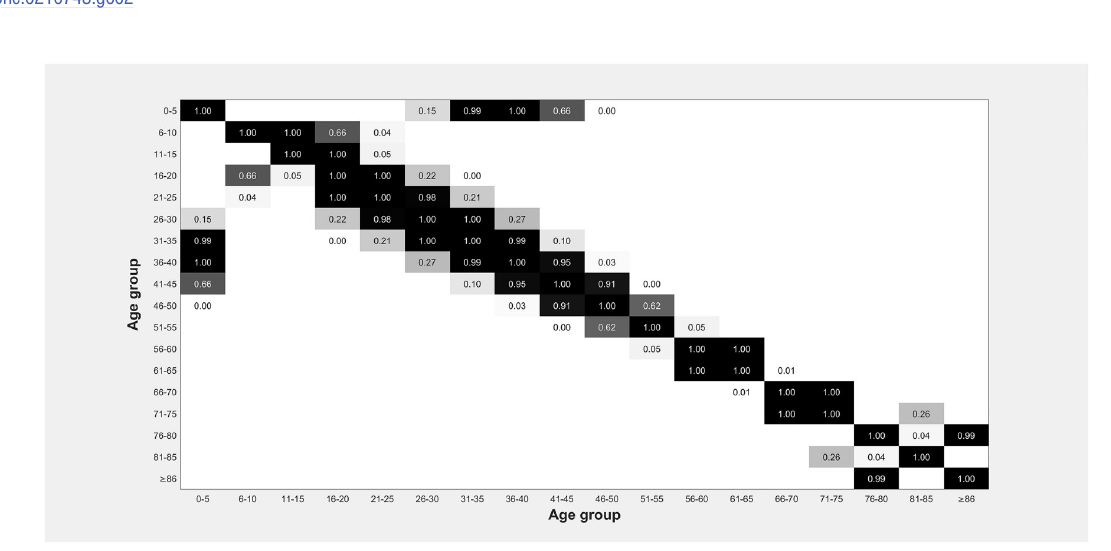
Fig 3. P-value matrix for the variable ‘treatment time’. Black cells indicate non-significant differences between age groups and significant difference with p = 0.000 are left out. The matrix shows that there are virtually no differences between the consecutive age groups for the considered